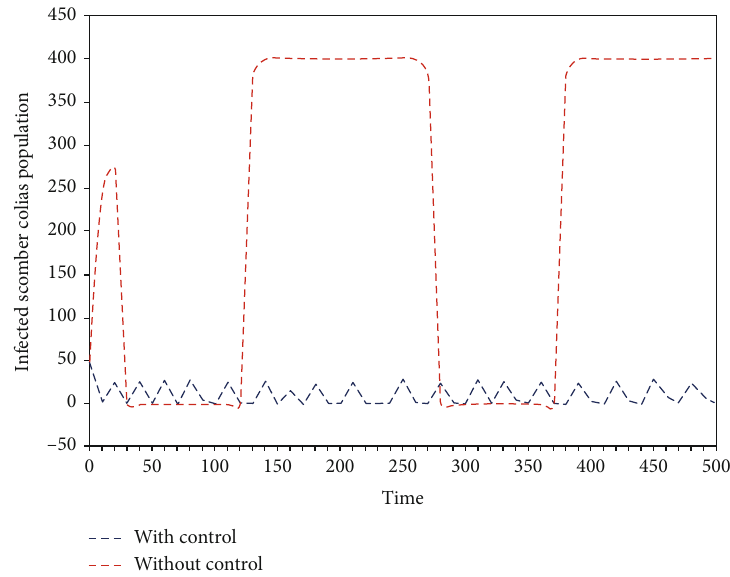
Figure 8: Infected Scomber colias population with optimal harvesting and e ff ort harvesting, with very low e ff ort.